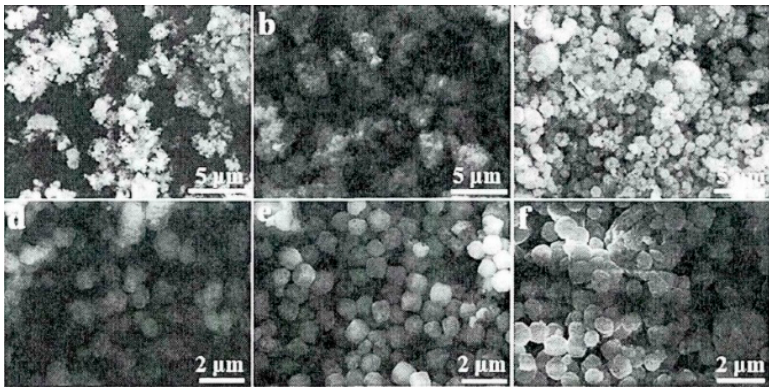
Figure 12. SEM picture of the effect of reaction time on morphology ( a ) 0 h; ( b ) 2 h; ( c ) 4 h; ( d ) 6 h; ( e ) 8 h; ( f ) 15 h [58].